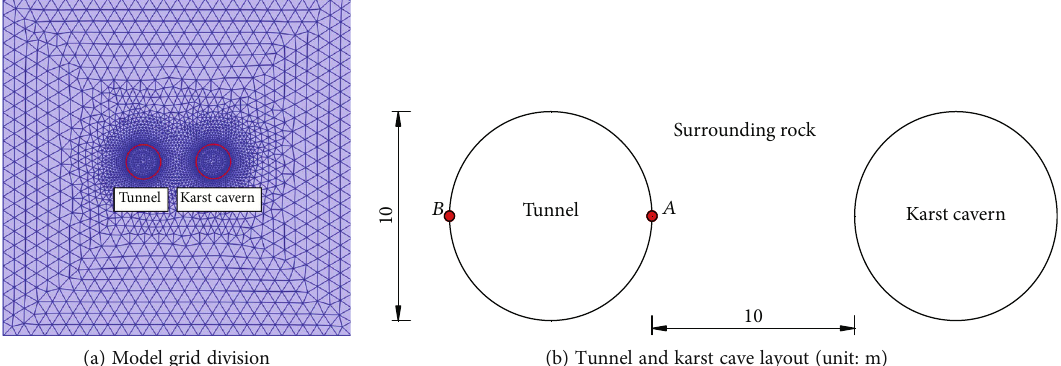
Figure 1: Two-dimensional geometric